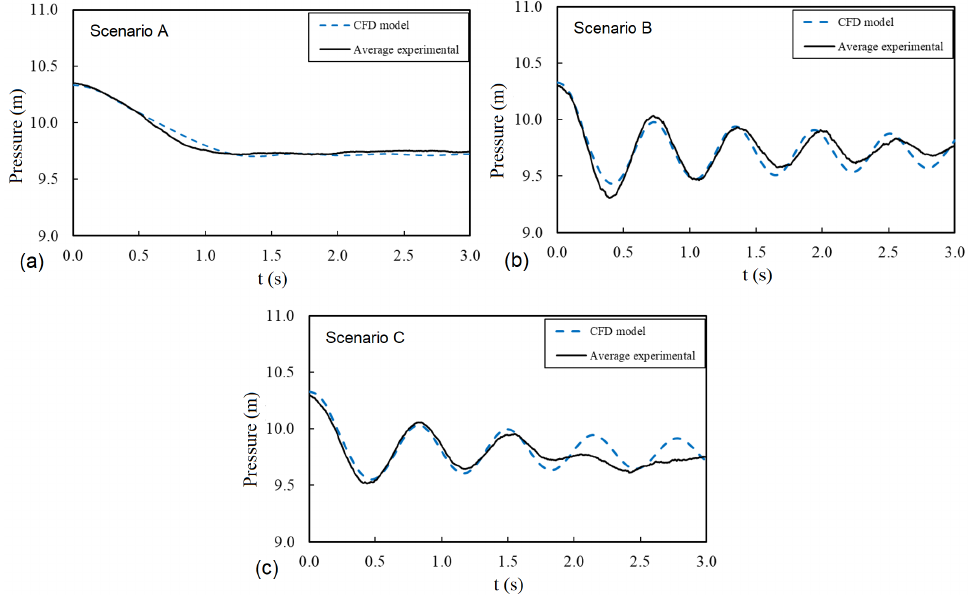
Figure 9. Undulating hydraulic system with trapped air pocket: two end points for draining, and no air valve.